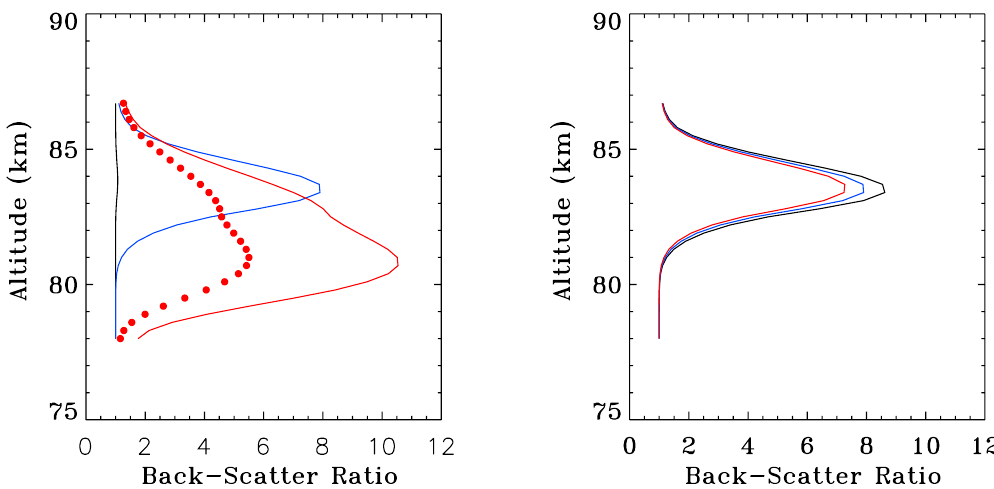
Fig. 1. BSR profiles at the time when the particle number density falls below ∼ 100cm − 3 due to variations in temperature and water vapour mixing ratio. (a) Reducing the “base-line” temperature, T , by 5% to 135K (blue solid line), and by 10% to 128K (red solid line); reducing T by 10% to 128K after 11h of particle growth (red dotted line). The water vapour remains constant at 4.7ppmv. (b) The BSR profile for a base-line water vapour mixing ratio of 4.7ppmv is given in blue. The BSR profiles corresponding to a 5% increase and 5% decrease in mixing ratio are given in black and red, respectively. The temperature is kept constant at